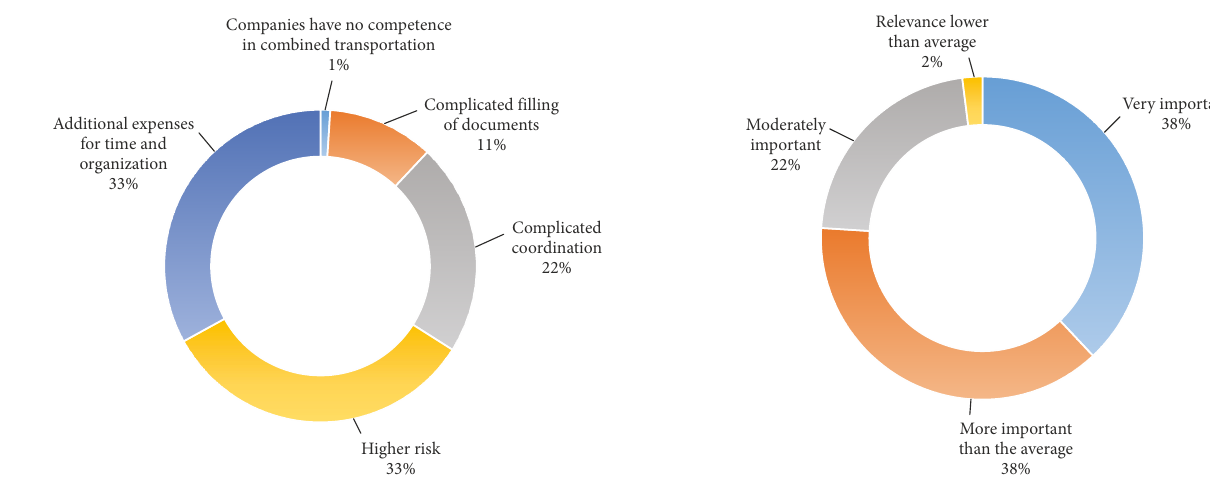
Figure 1. The reasons for not organizing railway and maritime Figure 2. The importance of ISs in organizing railway